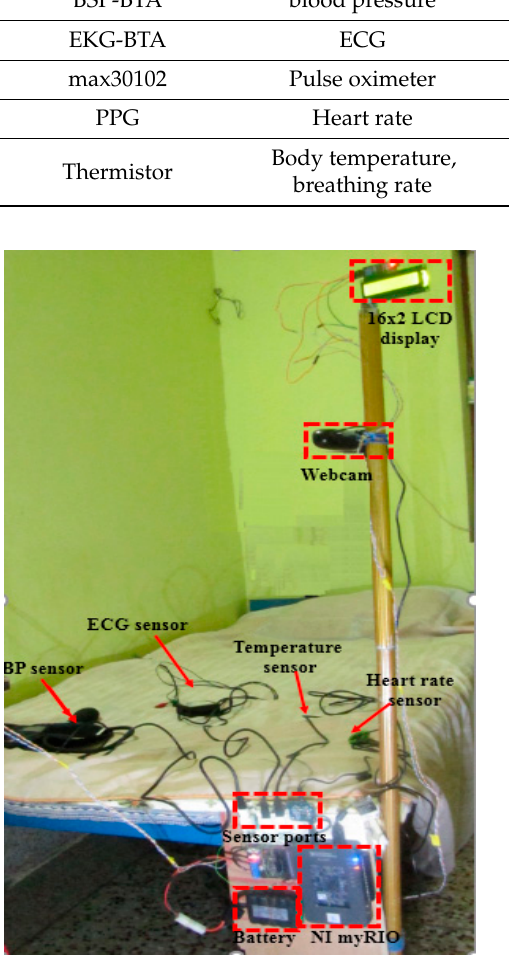
Figure 3 . Interface between myRIO-1900 and the sensors . Figure 3. Interface between myRIO-1900 and the